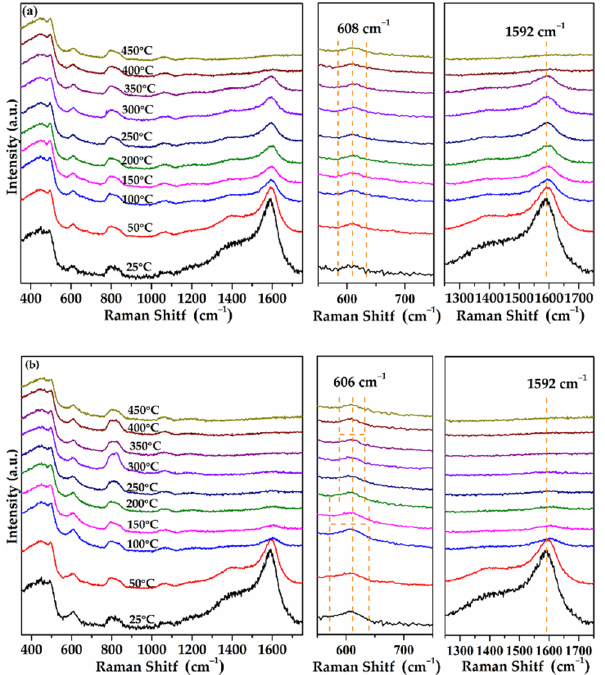
Figure 12. In-situ Raman spectra of MnCo 2 O 4 -HC ( a ) and Mn 0.7 K 0.3 Co 2 O 4 -HC ( b ) catalysts under laser wavelength of 325 nm. Reaction conditions: heating rate was 2 °C/min. The reaction atmosphere contained NO (2000 ppm), O 2 (10%) and He as equilibrium gas, and the total flow rate was 50 mL/min. Monolith catalyst maintains loose contact with soot.